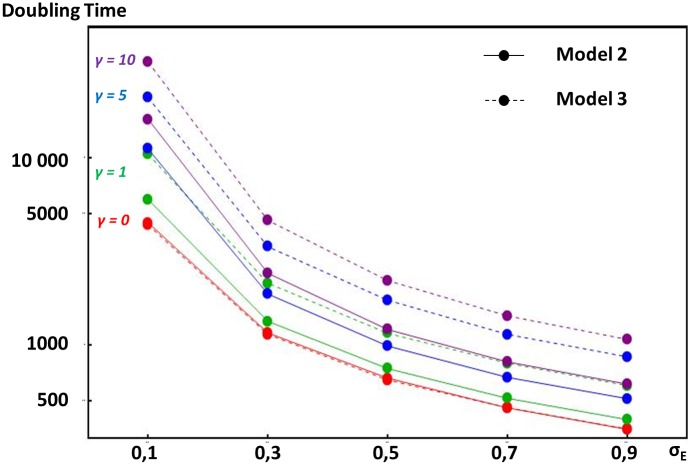
Comparative doubling times of enhancer strength escalation in models considering different selection pressures acting on overall gene expression.Y-axis indicates doubling times of enhancer strength (the expected number of generations needed to double the initial enhancer strength) according to the mutation size standard deviation on enhancers (x-axis). Because in all models presented, enhancer strength increases open-endedly in average, this doubling time measures the rate of escalation (see methods). The mutation size standard deviation on enhancer strength (σ
E) is a measure of the magnitude of mutational input (see methods). In model 2 (plain lines), overall expression of one gene is involved in a dosage relationship with the overall expression of another gene. Overall expression is determined by one enhancer locus per gene, and any departure from optimal dosage is costly. In model 3 (dashed lines), the absolute amount of protein produced is under stabilizing selection, but expression level is influenced by both an enhancer and a TF locus. In both models, stabilizing selection intensity is scaled by the intensity of selection at the gene locus (see methods). Deceleration of ER process due to stabilizing selection is illustrated for γ values equal to 0 (in red), 1 (in green), 5 (in blue) and 10 (in purple). Doubling times were obtained using stochastic simulations (see methods).